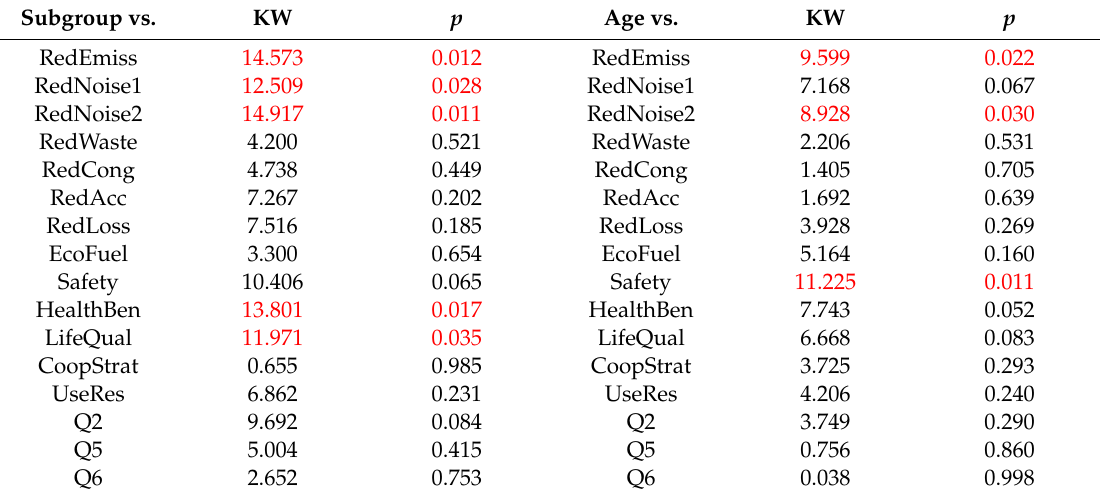
* the color red in the table signifies statistically important results with <